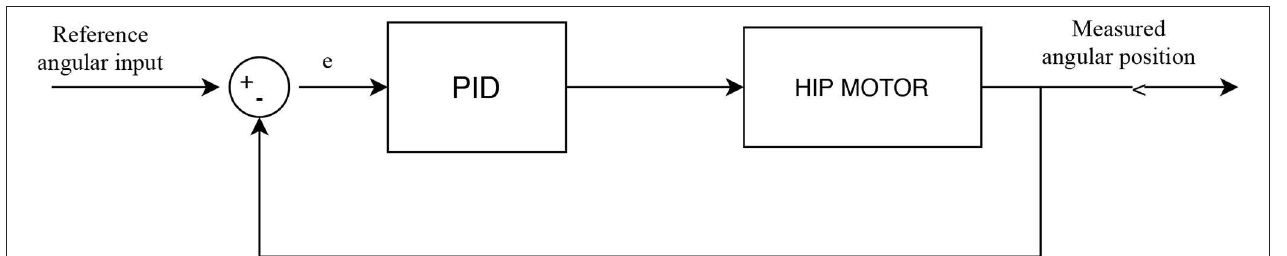
FIGURE 7 | Hip motor control